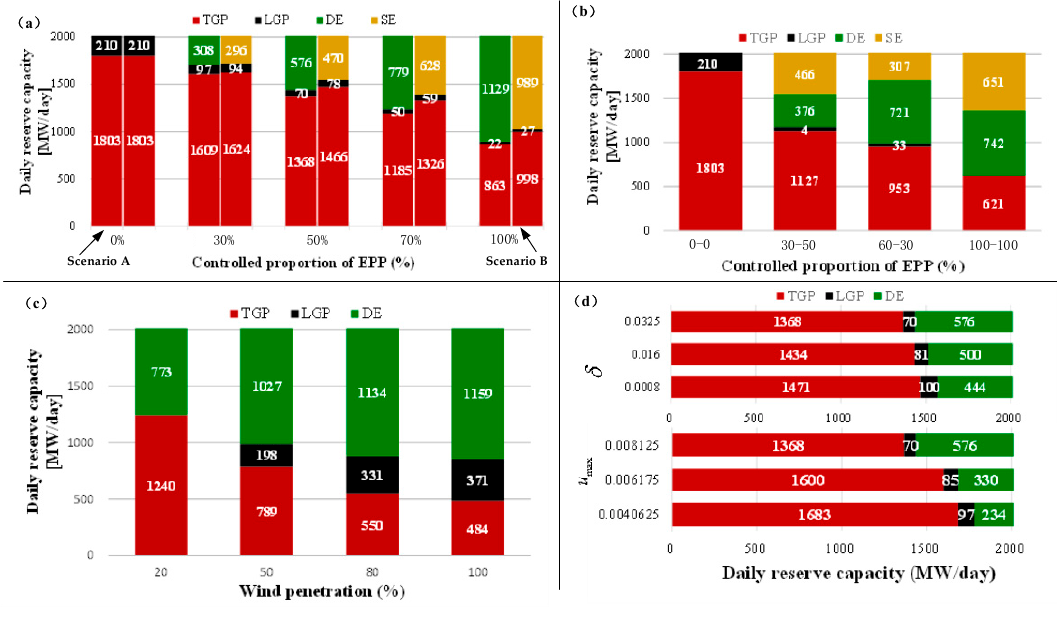
Figure 13. Daily electricity from the TGP and LGP for ( a ) Case-2, scenarios A and B; ( b ) Case-4, scenarios A and B; ( c ) Case-2, scenario C; and ( d ) Case-3.